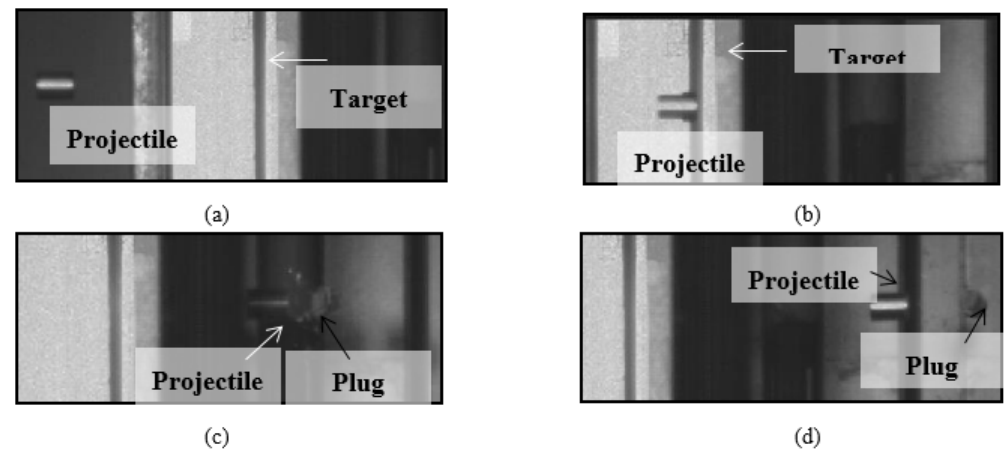
Figure 9. High ‐ speed camera sequence of the impact process to obtain Vo and Vr . ( a ) and ( b ) before impact imagens and; ( c ) and ( d ) after impact imagens.